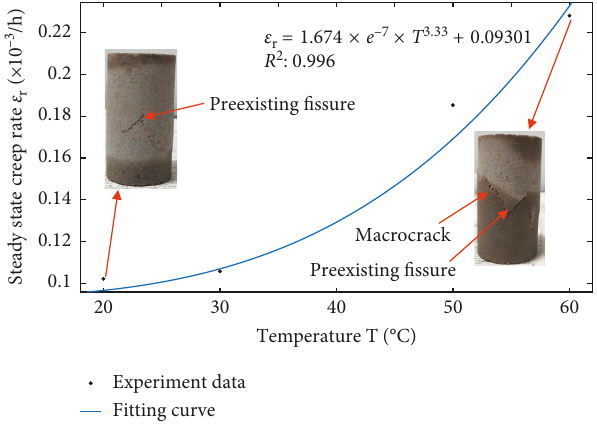
Figure 7: Steady-state creep rate at different temperatures (con- fining pressure � 0 MPa).